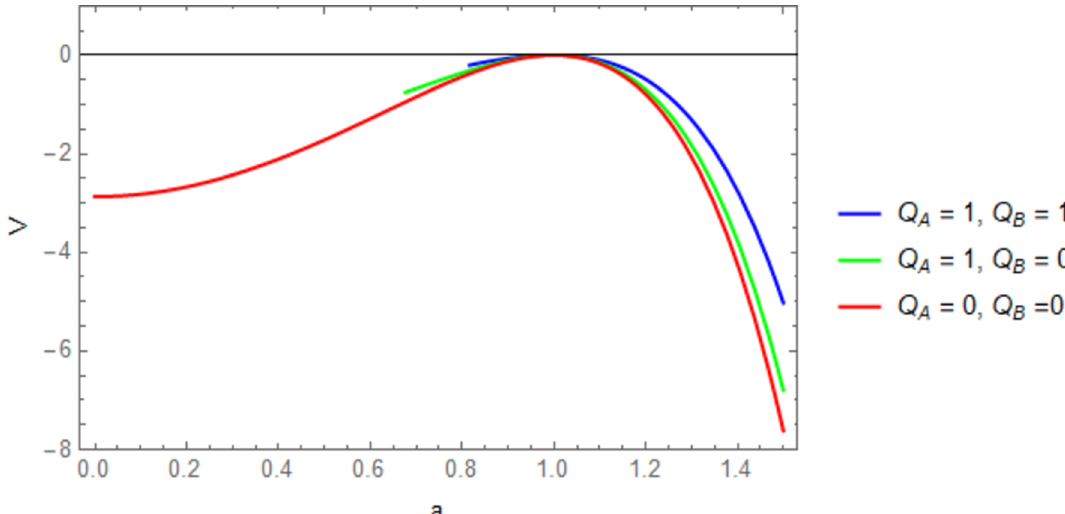
Figure 1 . The (cid:12)gure displays the shapes of the e(cid:11)ective potential of thermalon in values of the charges Q A and Q B with (cid:21) = 0 : 05, a ? = 1 and L = 1, d = 5 and (cid:27) =